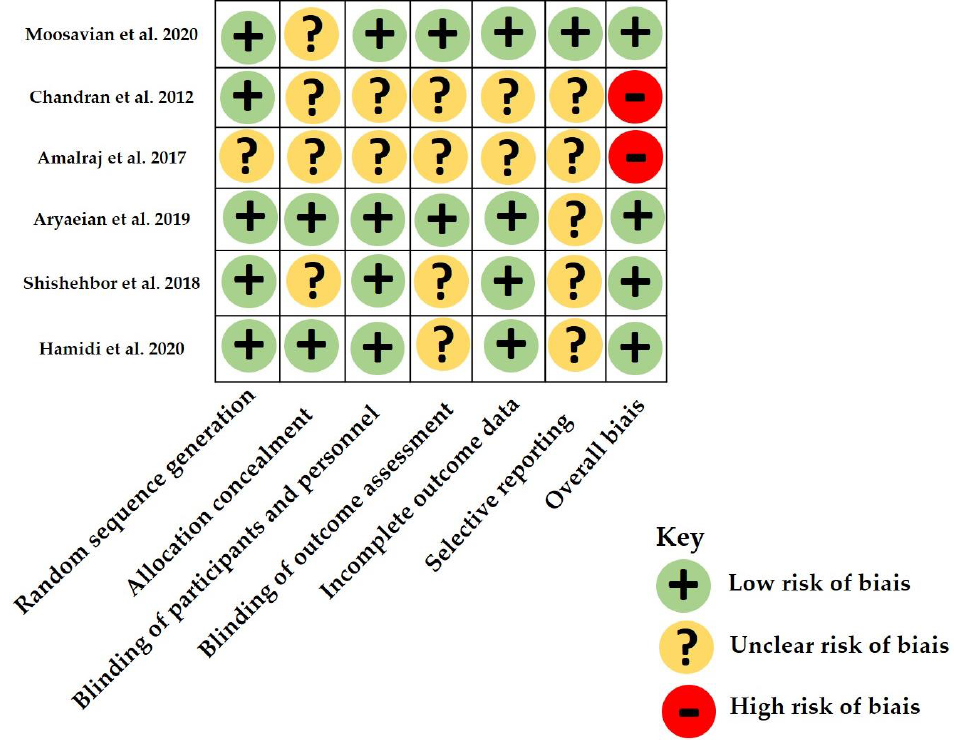
Figure 2. Summary of risk of bias according to the Cochrane Collaboration’s tool for the prevention trial.